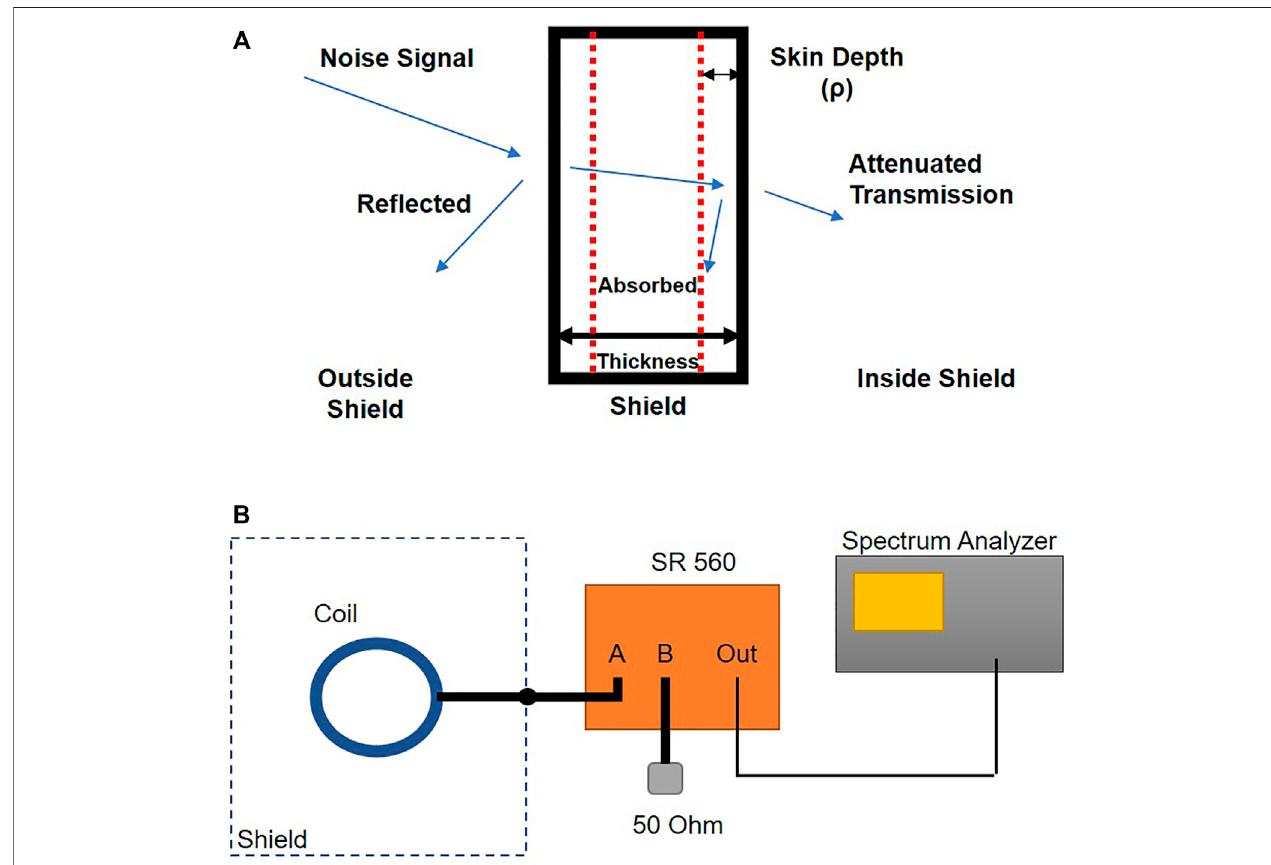
FIGURE5| ( A) Cross-sectionofanEMIshield.Interferencesignalsareshieldedbyexternalre fl ectionorabsorptionofRFenergy.Dependingontheef fi ciencyofthe shield,anattenuatedinterferencesignalisre-transmittedintotheshieldedspace. (B) Shieldtestsetup.Thecoilwasplacedinsideeachshieldwithcoilcablegroundedto the shieldand connectedtoinputAoftheSR560lownoiseampli fi er. A50ohmresistorwasconnectedtoinputBoftheampli fi er. Output wasmeasured byaspectrum analyzer.